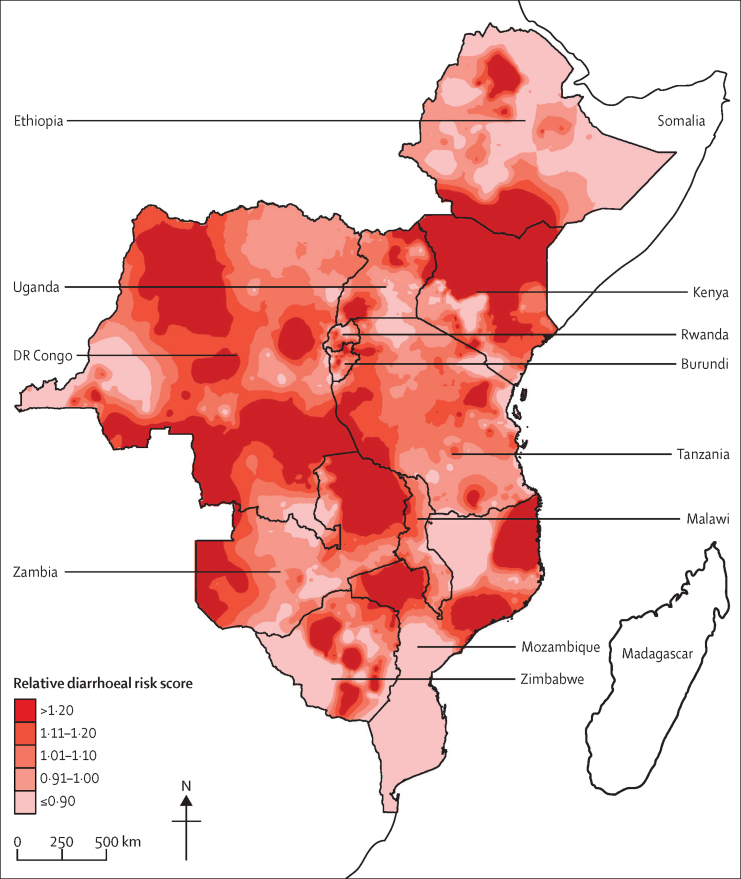
Heat map of relative diarrhoeal risk for children younger than 5 years across 11 eastern and central African countriesDisplayed surfaces are of spatial interpolations (predictions) estimated from cluster-level average diarrhoeal risk calculations using data from national Demographic and Health Surveys. Higher numbers indicate higher risk.